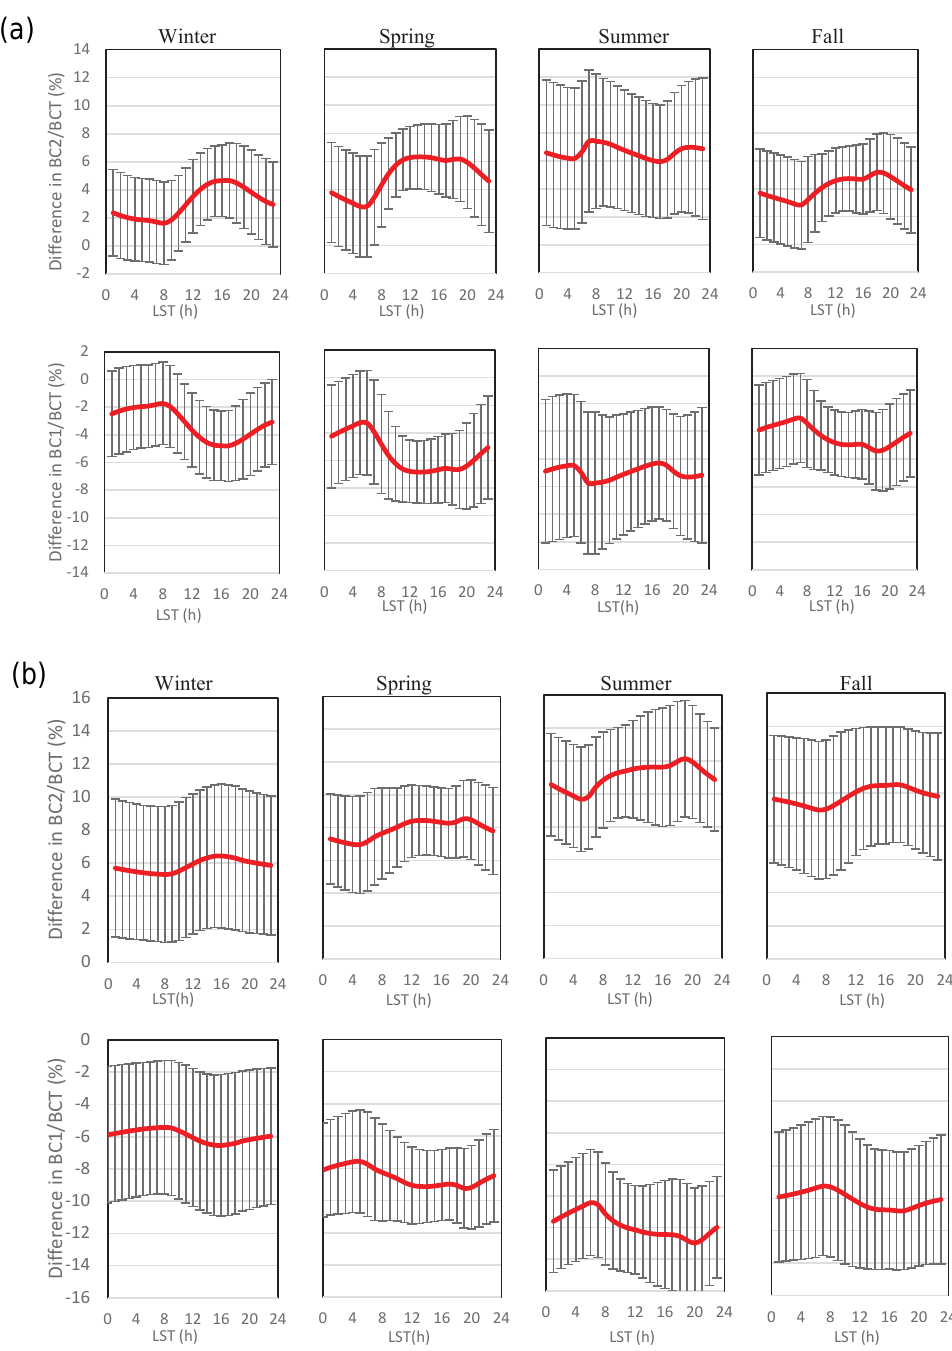
Figure 9. (a) Differences in the seasonal averaged diurnal cycles of BC2 / BCT (in percentage) and in BC1 / BCT (in percentage) between WRF / CAMx and WRF / CMAQ_27aL (WRF / CAMx minus WRF / CMAQ_27aL) over the WB subregion. For each season and hour, the regional average is shown in red with the standard deviation shown in black bars. Panel (b) is the same as (a) , but over the NB